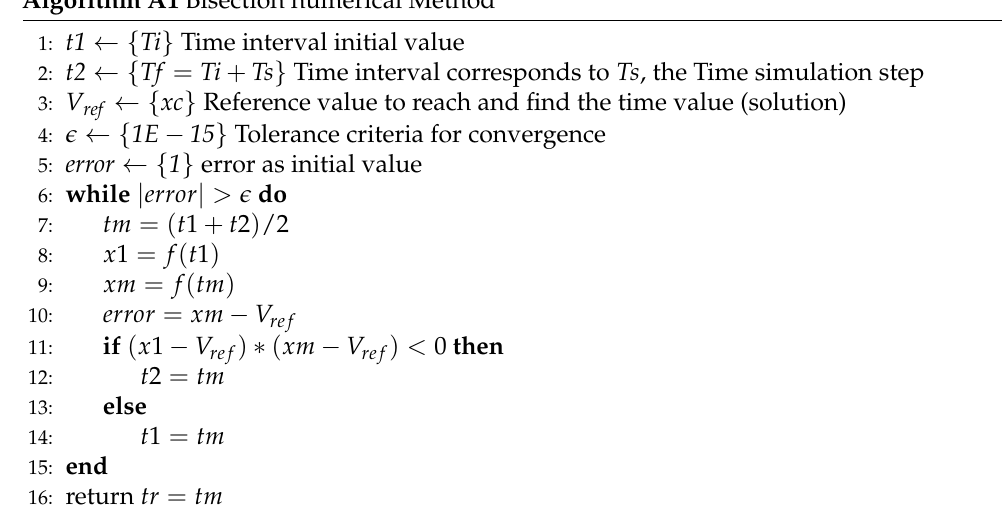
Algorithm A1 Bisection numerical